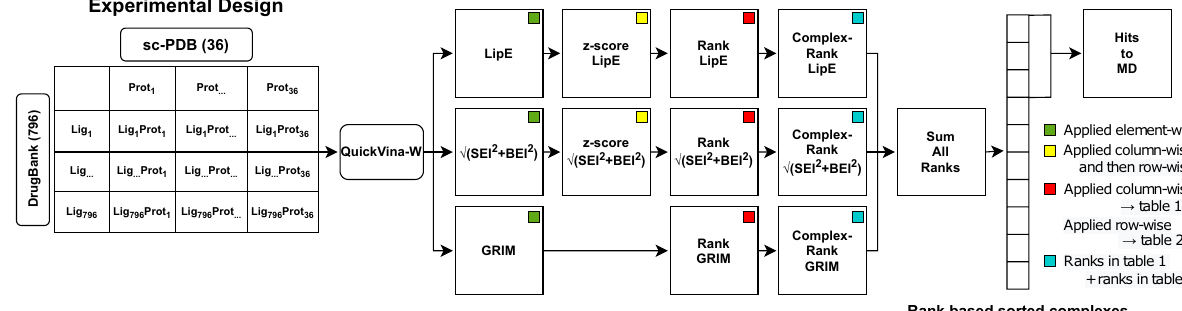
Figure 2. Virtual screening workflow. Square boxes represent tables of protein–ligand systems as described in the experimental design. Values in the table are given by the metric in the box center. Colors code the type of operation applied on each